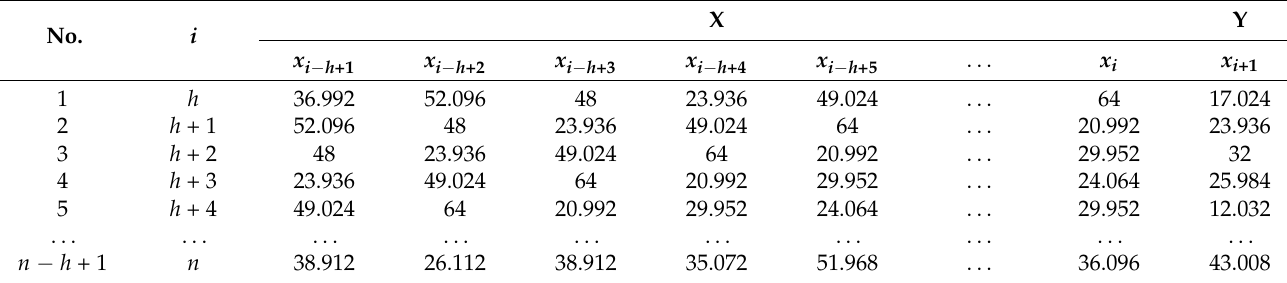
Table 1. Preparation of the